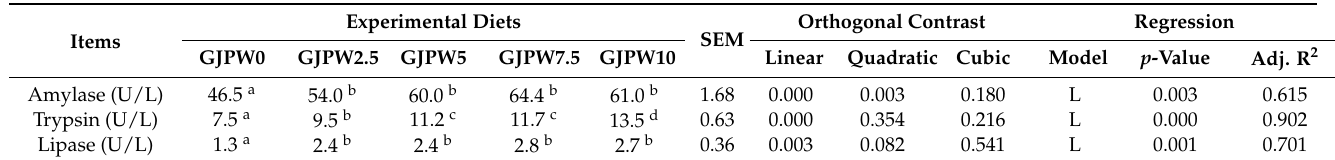
Table 7. Digestive enzyme activities of juvenile rockfish fed with different levels of garlic juice processing waste (GJPW) inclusion in